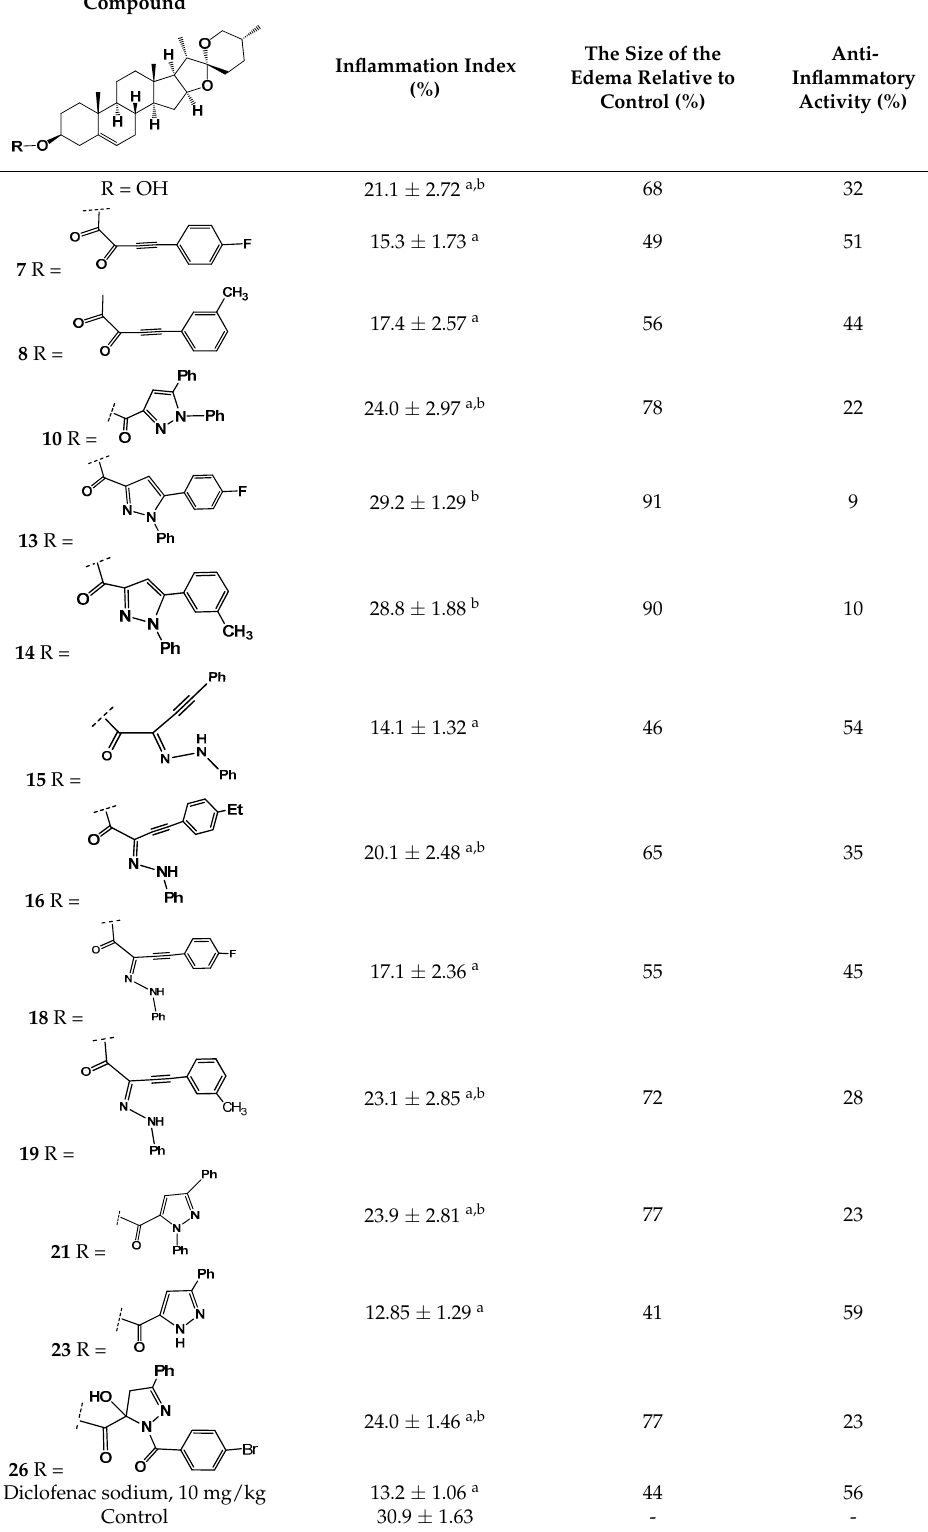
Table 4. Anti-inflammatory activity of diosgenin 1 and its 3- O -substituted derivatives in the his- tamine-induced paw edema model.